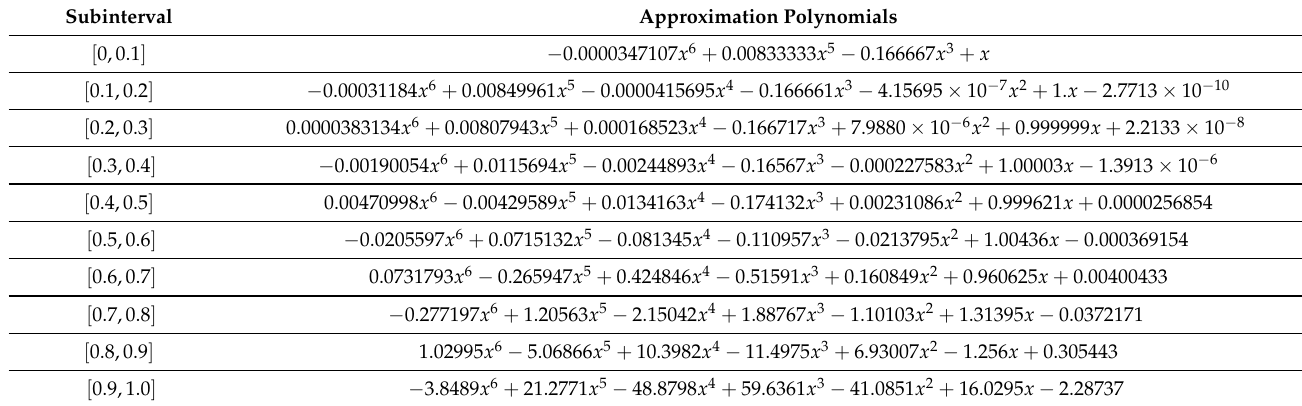
Table 1. Approximation spline for the problem (29).